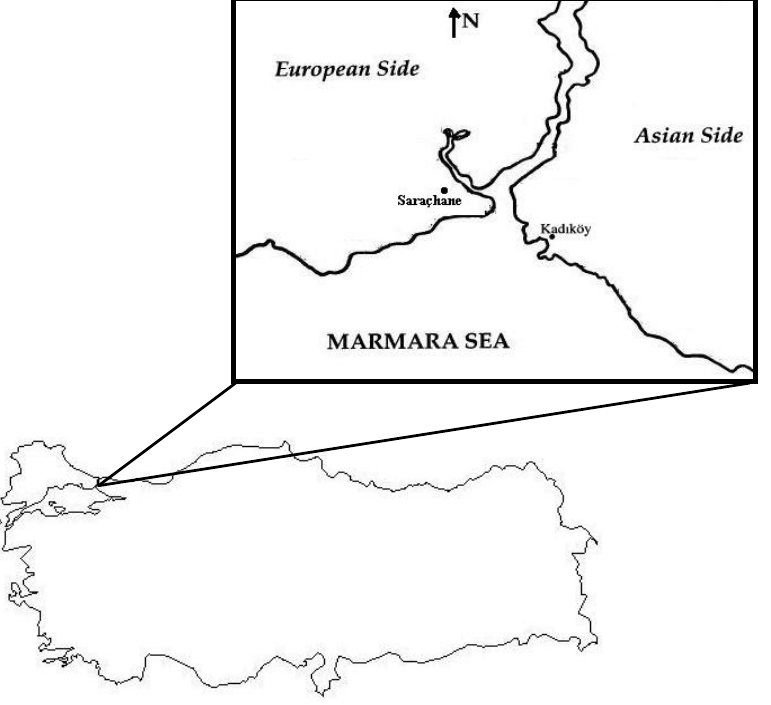
Figure 1. Study area and the air pollution